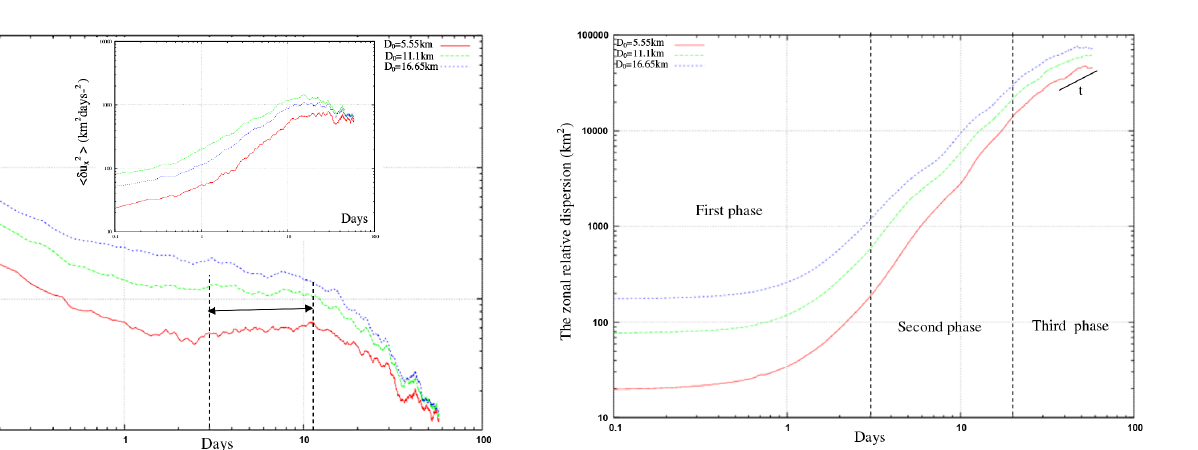
Fig. 4c. Temporal evolution of the mean square relative velocity divided by t for different initial separation distances. The plateau indicates the linear < δu 2 x > law. In the inset, the temporal evolution of < δu 2 x > in km 2 days − 2 is shown.